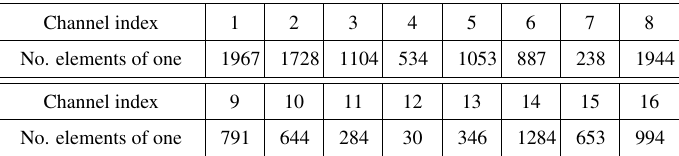
Table 3. The number of M s that equal to 1 for each channel in the feature mask M . i,j